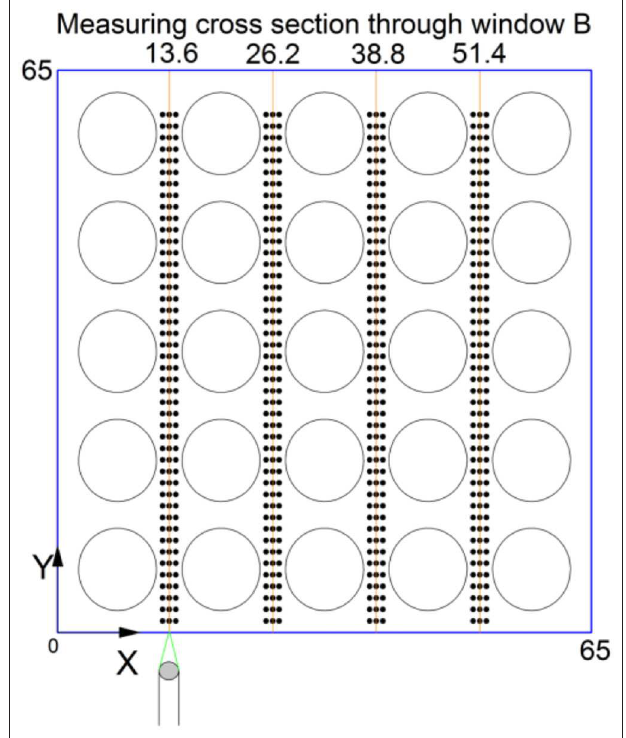
FIGURE 3 | Measuring position in the cross section downstream of the first spacer grid.